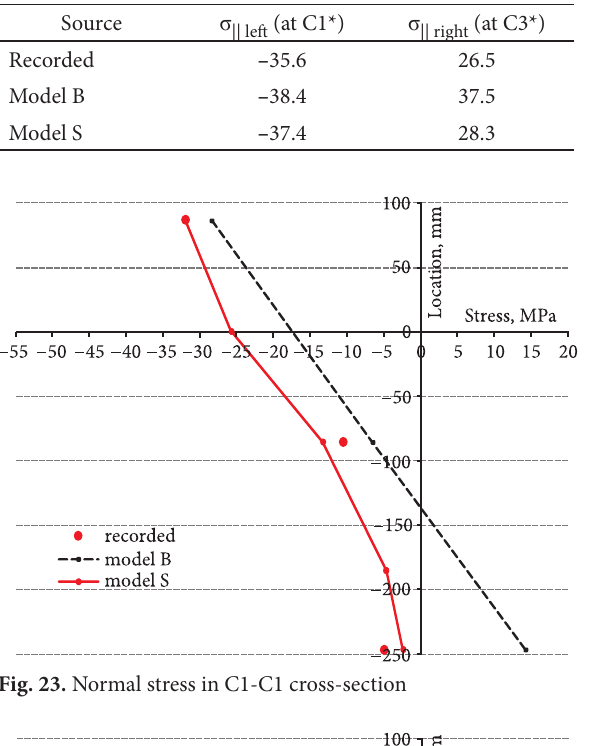
Table 5. Normal stress parallel to bracing members